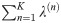
Comparison between the PCA and CHPCA eigenvalues.In each case, the partial sum of the eigenvalues, ∑n=1Kλ(n) (y-axis) versus K (x-axis), for PCA (blue and dashed) and for CHPCA (green and solid). The fact that the CHPCA sums of eigenvalues are always above PCA-based eigenvalue sums shows that CHPCA is a stronger analytic tool in identifying important co-movements.